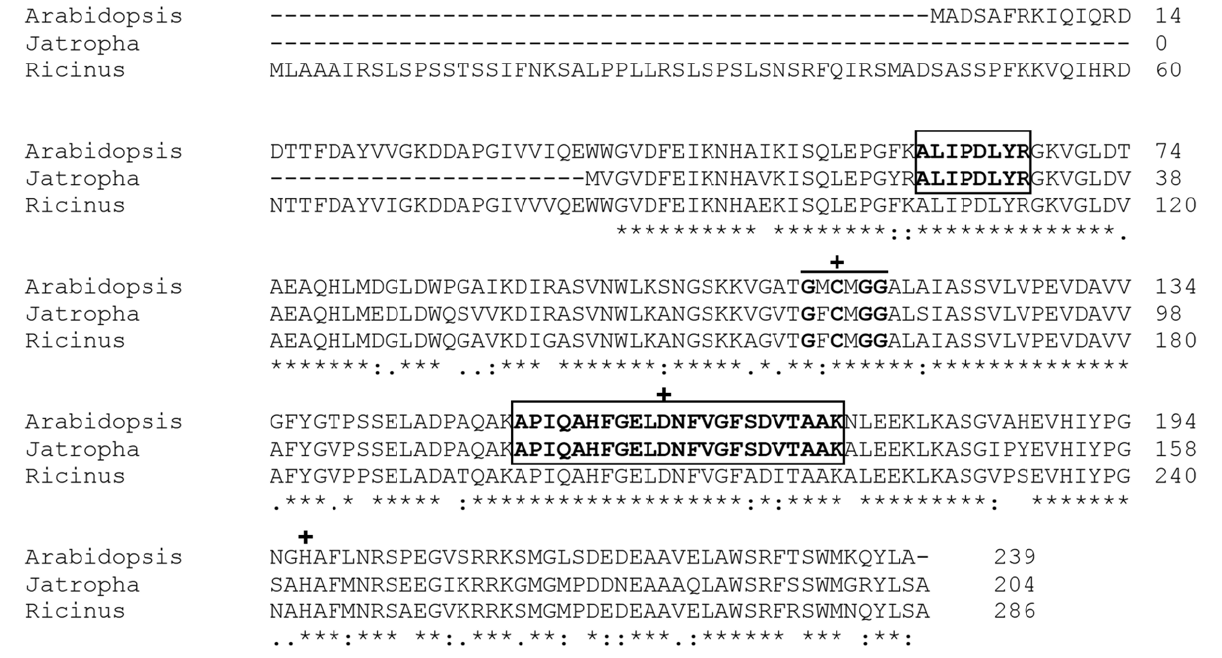
Figure 5. Alignment analysis of A. thaliana carboxymethylenebutenolidase and its homologs in J. curcas and R. communis . Both peptides identified during the mass spectrometry analysis are shown within rectangles. The typical dienalactone hydrolase pentapeptide (GxCxGG) is highlighted, as well as the active site residues Cys-78, Asp-126, and His-161 (marked with +). (*) Conserved sites, (:) sites with conservative replacement, (.) sites with semiconservative replacement.